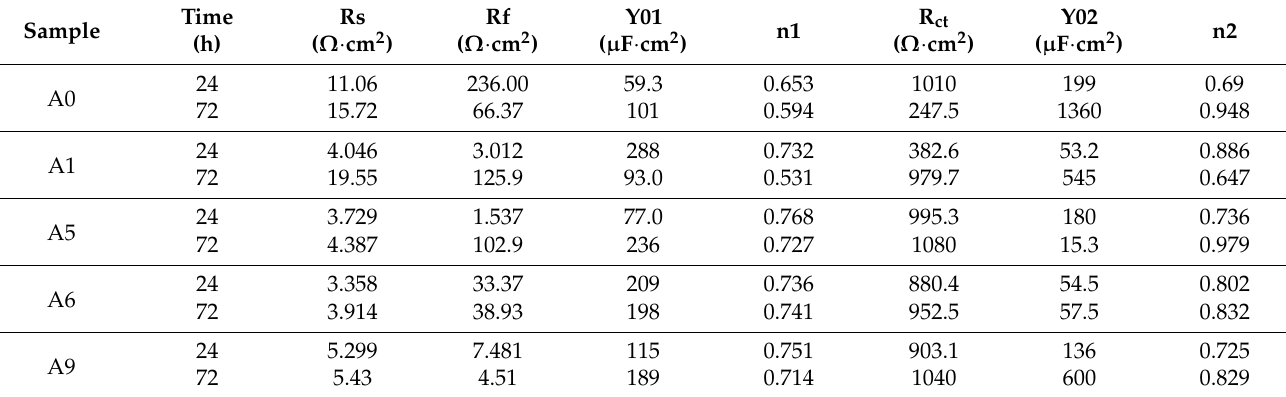
Table 4. Fitting parameters for EIS spectra of samples in 3.5% NaCl solution at 24 and 72